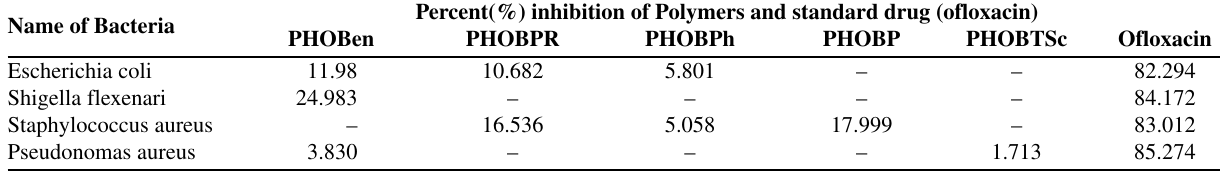
Table 3: Antibacterial activities of polymers Name of